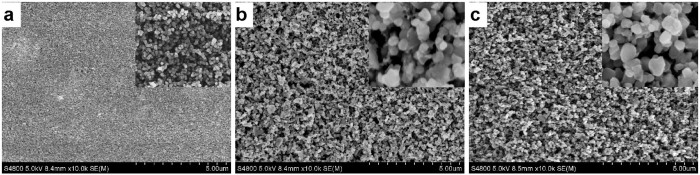
Top view SEM images of nanocrystalline TiO2 electrodes.(a) 6 type; (b) 6+1 type; (c) 1+1 type. Inner images' width 1 μm.